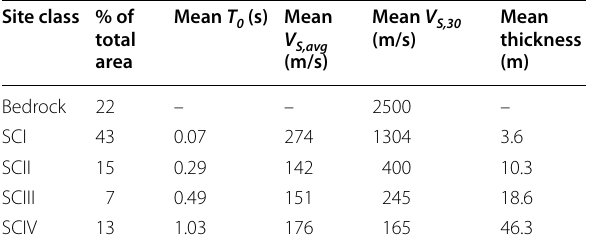
Table 8 Descriptive statistical parameters of site classes